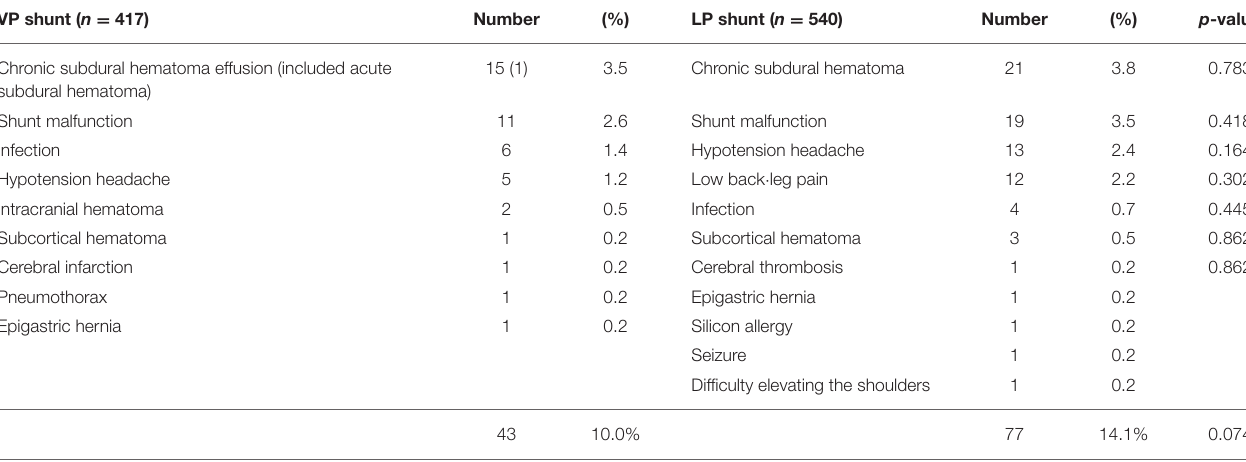
TABLE 3 | Differences in complications due to differences in shunt treatment method (ventriculoperitoneal shunt vs. lumboperitoneal shunt). VP shunt ( n = 417) Number (%) LP shunt ( n = 540) Number (%) p -value Chronic subdural hematoma effusion (included acute subdural hematoma)